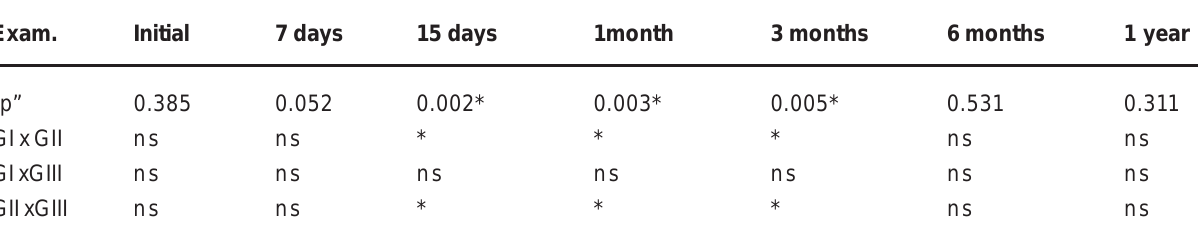
ns – non-significant *significant GI, GII, GIII – groups I, II and III.